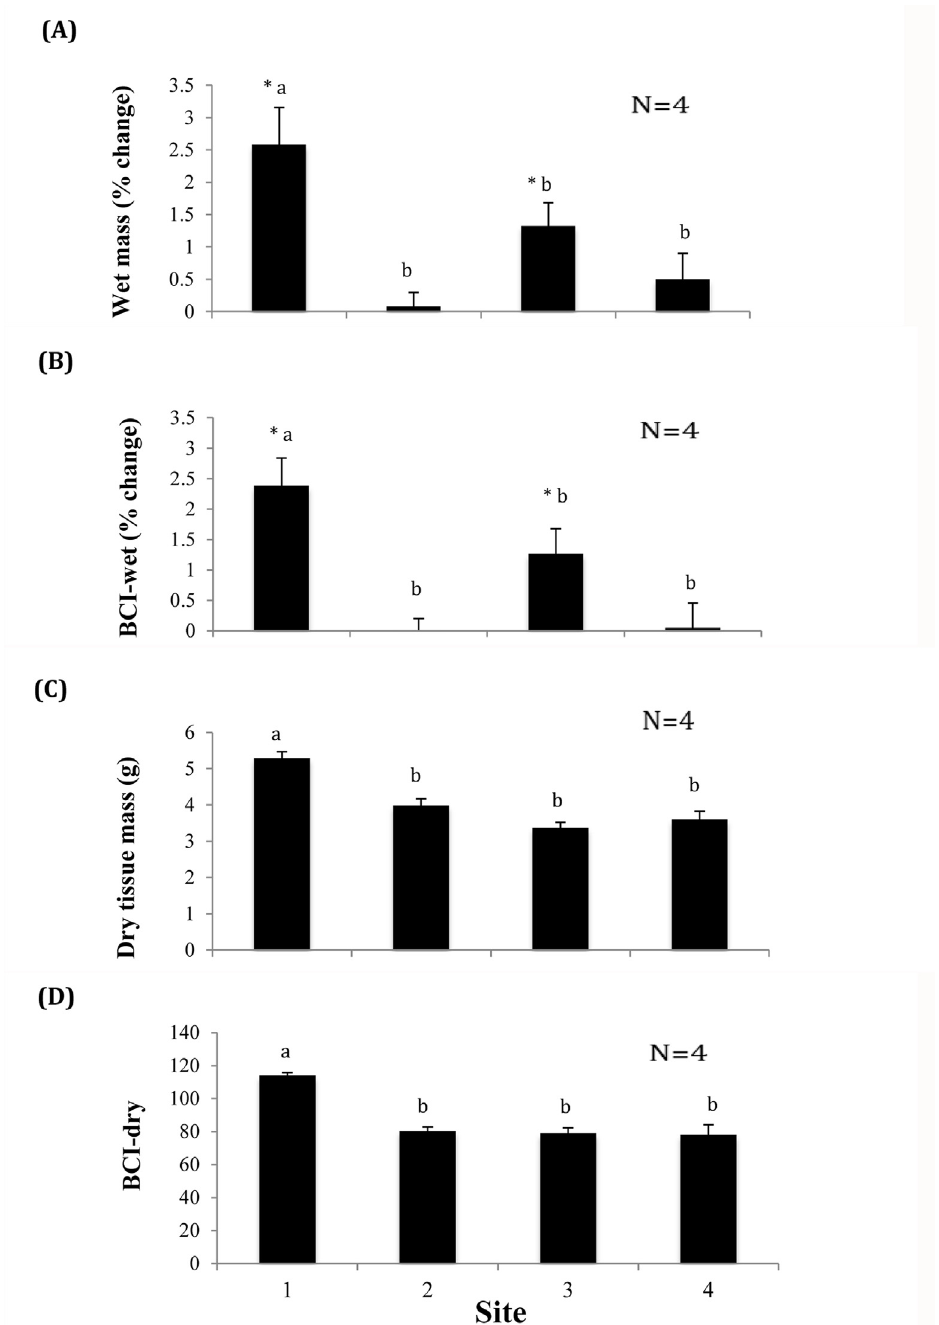
Fig 2. Physical responses of the native threeridge mussel ( Amblema plicata ) to effluent in the 72-day exposure experiment at four sites in Wilbarger Creek (Texas, USA). Error bars represent ± 1 standard error. Columns with the same letter were not statistically different from each other at p = 0.05. (A) and (B) represent change in pre-exposure (day 0) and post-exposure (day 72) wet mass and condition index respectively. An asterisk next to a column denotes significant (p < 0.05) change in that parameter between day 0 and day 72. (C) and (D) represent post-exposure data only. Site 1, the reference site, was located upstream of the discharge, Site 2 just below the discharge, and Sites 3 and 4 downstream of the